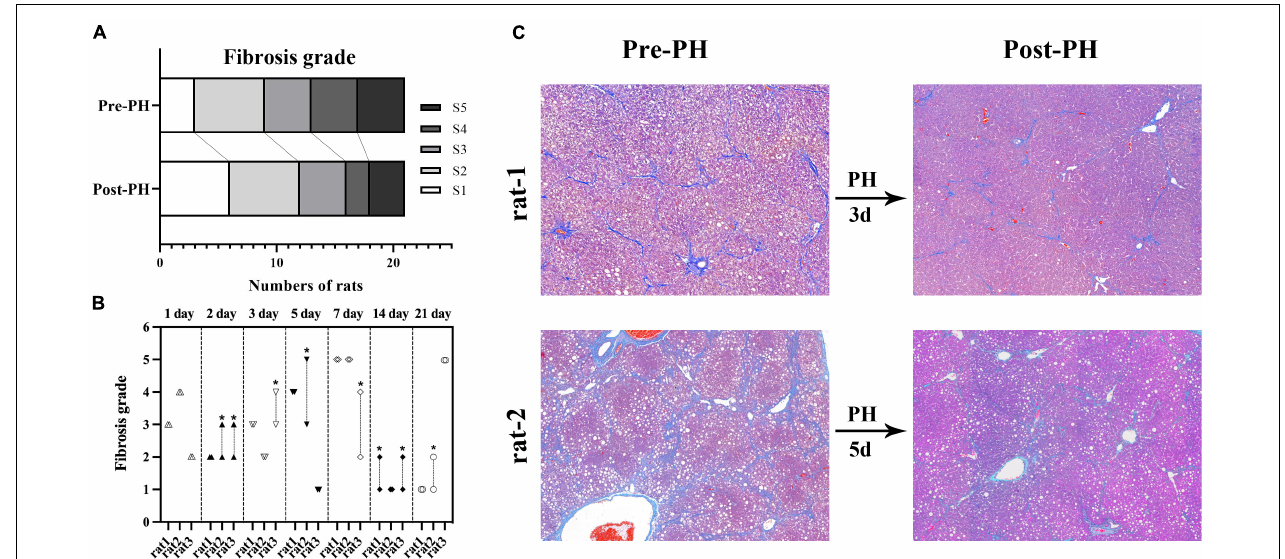
FIGURE 4 | Fibrosis grade reversal after PH in fibrosis group (A) . Changes of fibrosis grades of all rats in fibrosis group. Eight rats had a decreased fibrosis grade (*, the upper and lower symbols correspond to fibrosis grade before and after PH, respectively), and the other 21 rats showed no change (B) . A representative example in rat-1, Masson’s trichrome (MT) staining of all liver samples from baseline and 3 days post-PH showed grade 3 liver fibrosis. A representative example in rat-2, MT staining of liver samples from baseline showed grade 5 liver fibrosis, and the sample from 5 days post-PH shows liver grade 3 liver fibrosis (C) . CCl 4 , carbon tetrachloride; PH, partial hepatectomy.